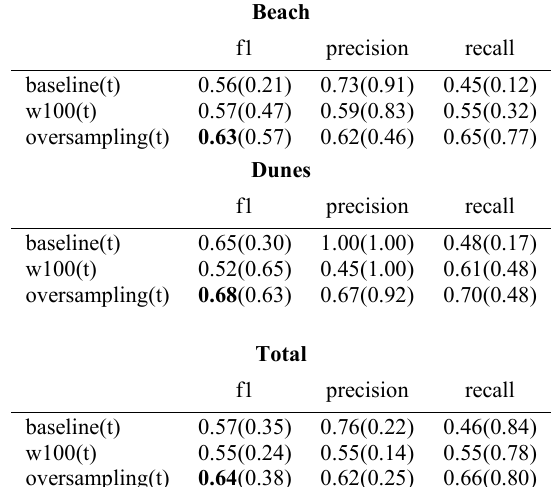
experiments baseline, weighting